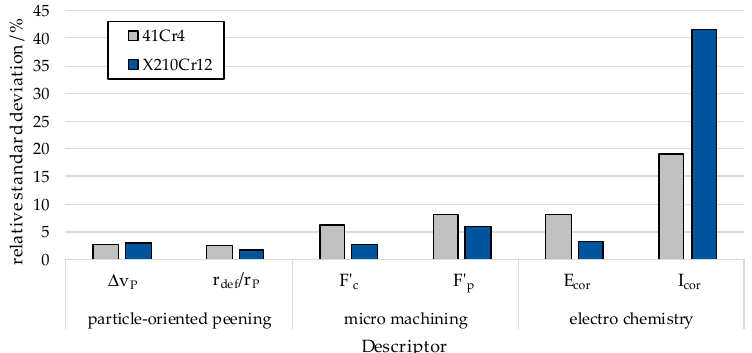
Figure 10. Relative standard deviation of determined descriptors for both materials.